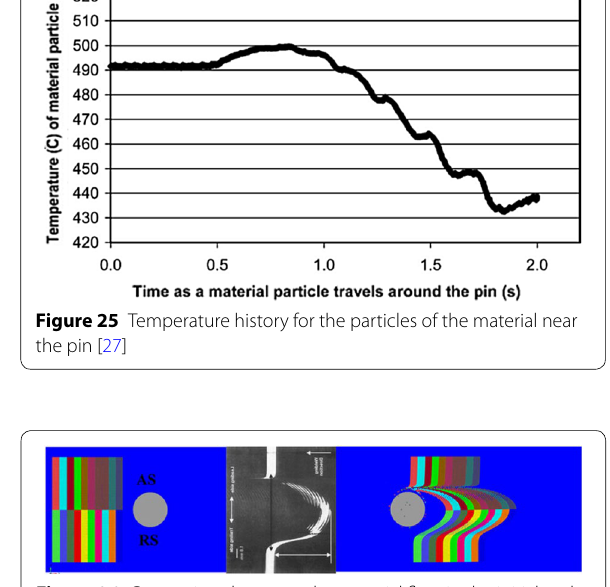
Figure 26 Comparison between the material flow in the initial and the welding steps